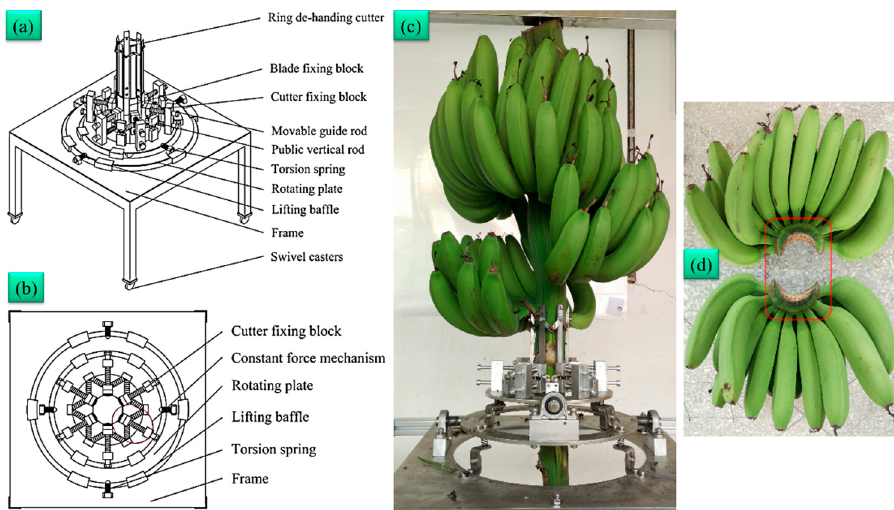
Figure 14. De ‐ handing mechanism based on constant force mechanism. ( a ) Axonometric view of de ‐ handing mechanism, ( b ) Top view of de ‐ handing mechanism, ( c ) Schematic diagram of de ‐ handing experiment, ( d ) Incision of banana hands after de ‐ handing.